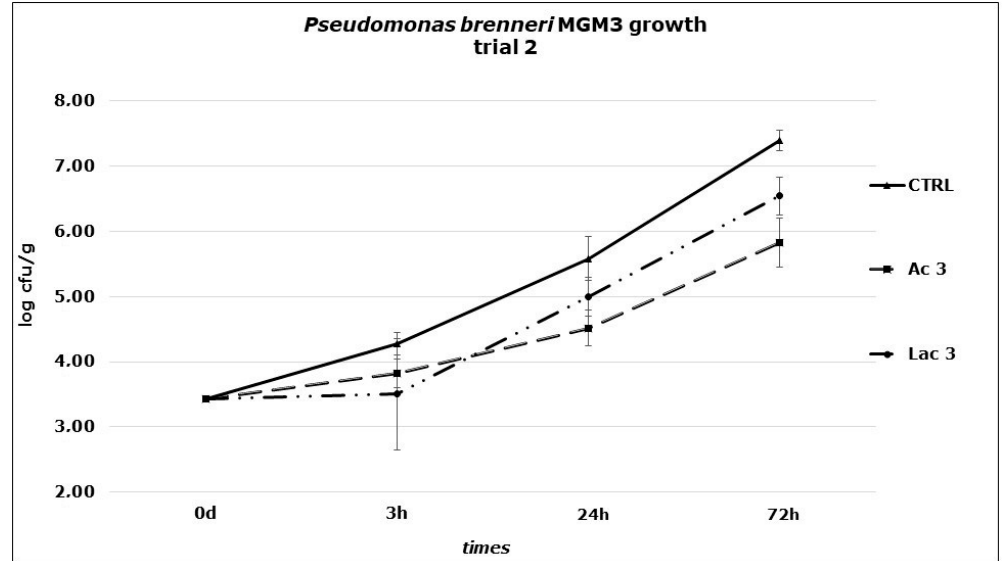
Figure 2. P. brenneri MGM3 counts obtained in Primo sale cheese during the second challenge test performed at 6 °C. Dipping: Ac3: acetic acid, 149.89 mM; Lac3: lactic acid, 133.20 mM; CTRL: distilled water.